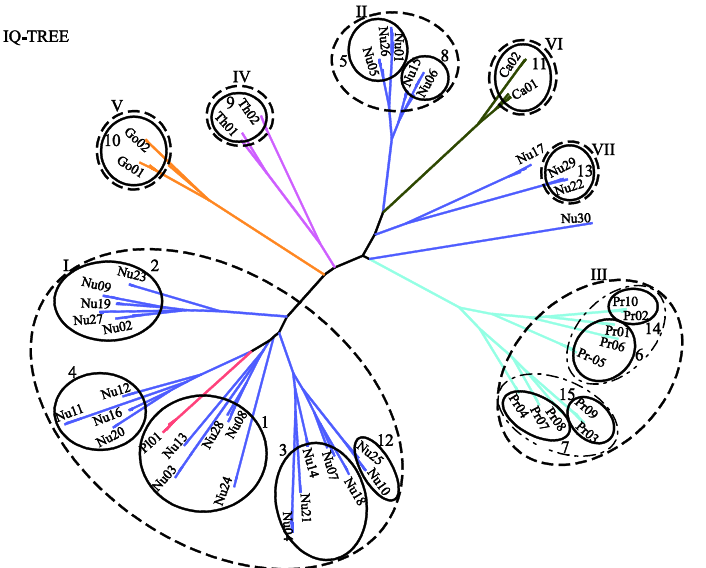
Figure 6. A character-based phylogenetic tree of the GPCR network, as constructed by IQ-TREE using the Q.mammal+R6 model. Each branch is colored according to GPCRdb’s classification.